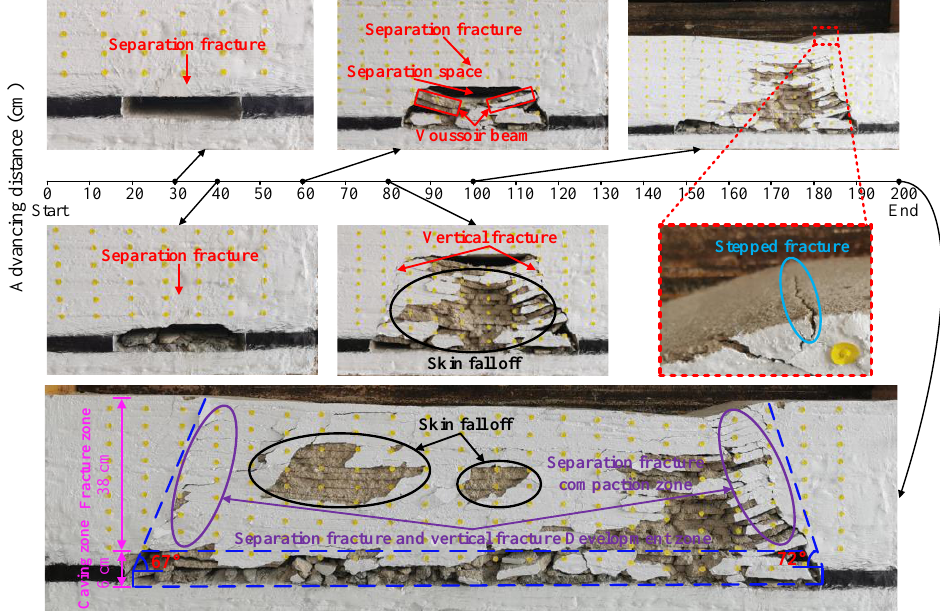
Figure 6. Overburden migration and fracture development.